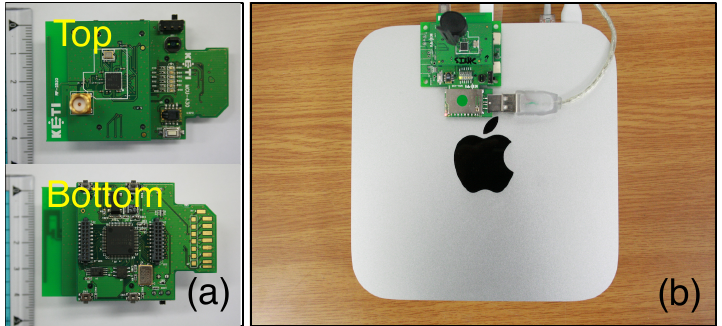
Figure 1. ( a ) a ZigBee-based sensor node equipped with temperature, humidity, and light sensors, ( b ) a ZigBee receiver connected to a Mac mini.